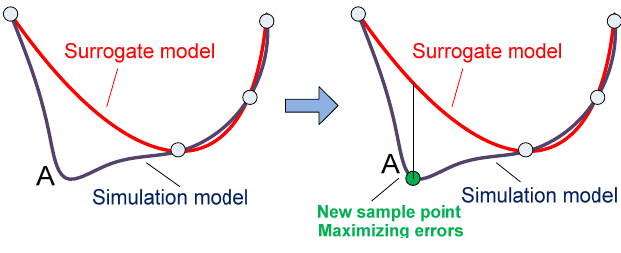
Figure 1. Adaptive sampling